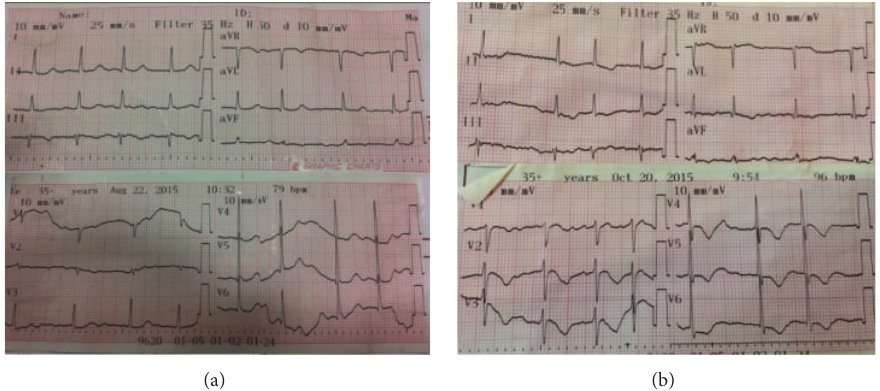
Figure 2: (a) Baseline EKG with no significant changes; (b) EKG with negative T waves in all precordial leads.